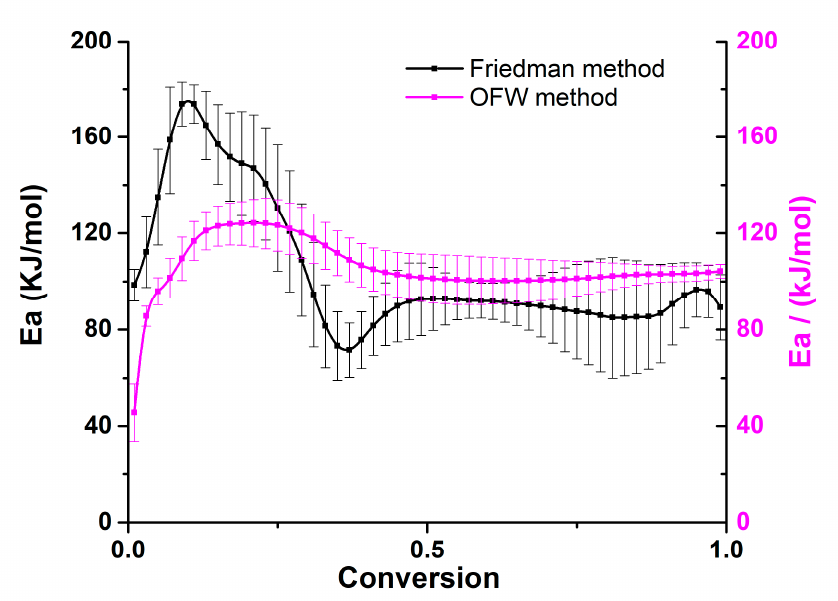
Figure 16. Activation energies calculated using Friedman analysis (black) and the Ozawa − Flynn − Wall method (magenta) in air.